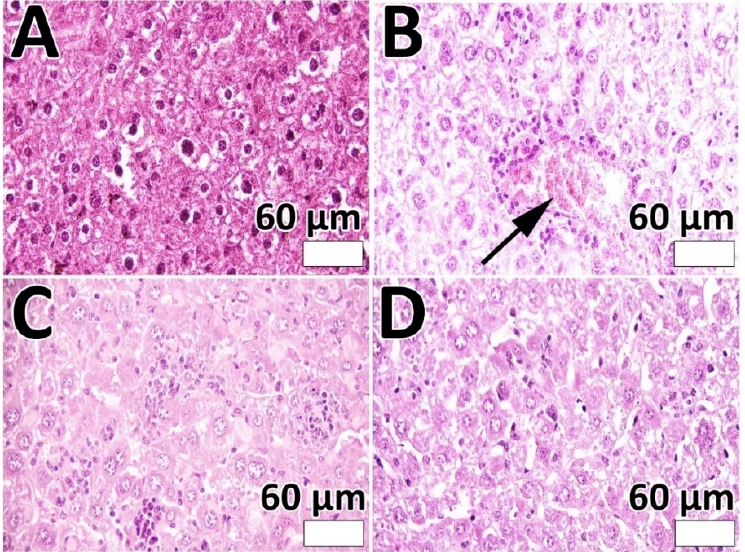
Figure 7. Results of liver histopathological studies in ( A ) control; ( B ) DOX + CB; ( C ) Lip-DOX/CB; and ( D ) PEG-Lip-DOX/CB receiver groups. As the results show, no cellular damage was observed in control, Lip-DOX/CB, and PEG-Lip-DOX/CB receiver groups; however, liver cell necrosis (arrow) was observed in DOX + CB group. (Magnification ×40).